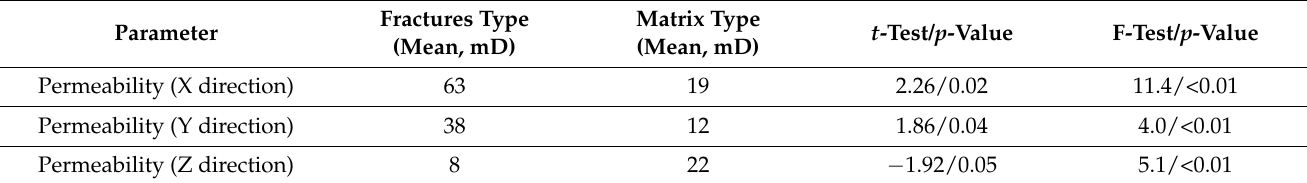
Figure 2. Results of x-ray tomography study of rock samples: ( a ) XY slice; ( b ) YZ slice; ( c ) 3D model of pore space.